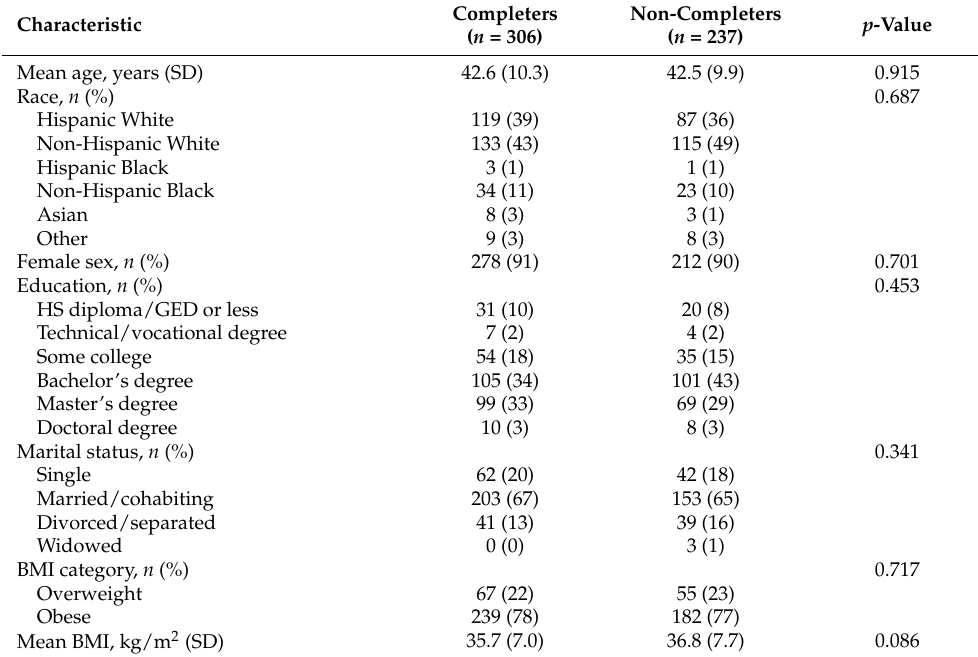
BMI = body-mass index; GED = general educational development; HS = high school; SD = standard